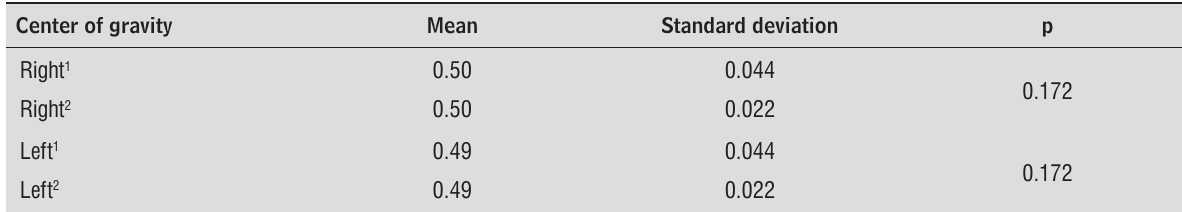
Table 5 - Analysis of the center of gravity in the 1 st and 20 th